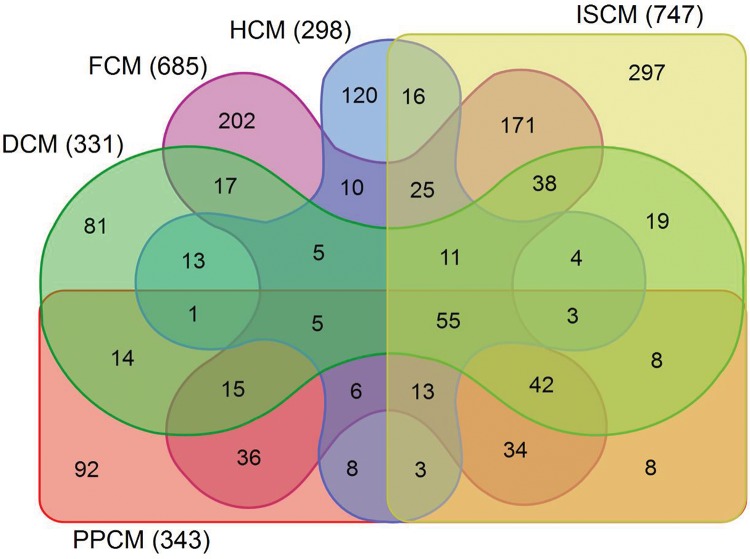
Overlapping DEGs among the groups of different etiologies. The Venn graph displays the number of differentially expressed genes overlapping among the different etiologies. The differentially expressed genes (DEGs) shown in the figure differ significantly in their expression value with an adjusted p-value <0.05 and a fold change >2. DCM, dilated cardiomyopathy; HCM, hypertrophic cardiomyopathy; FCM, familial cardiomyopathy; ISCM, ischemic cardiomyopathy; PPCM, post-partum cardiomyopathy.